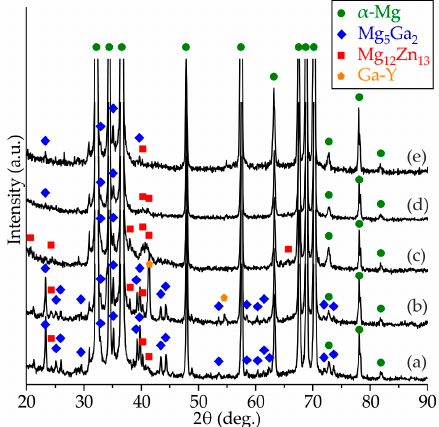
Figure 8. Average grain size vs. extrusion temperature of the Mg–Zn–Ga–(Y) alloys.